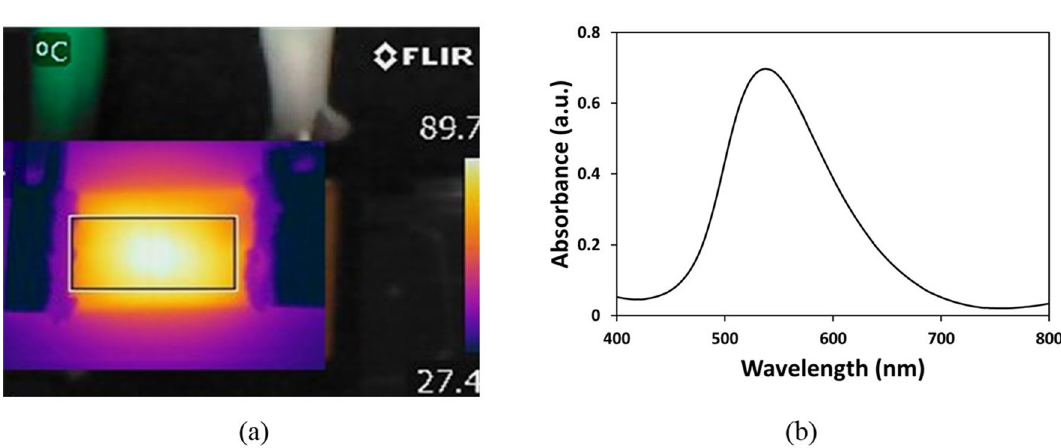
Figure 5. ( a ) Image from thermal camera showing the temperature maintained at 89.7 °C at 6.5 V ( b ) UV visible spectrum obtained for GNP using microfluidic